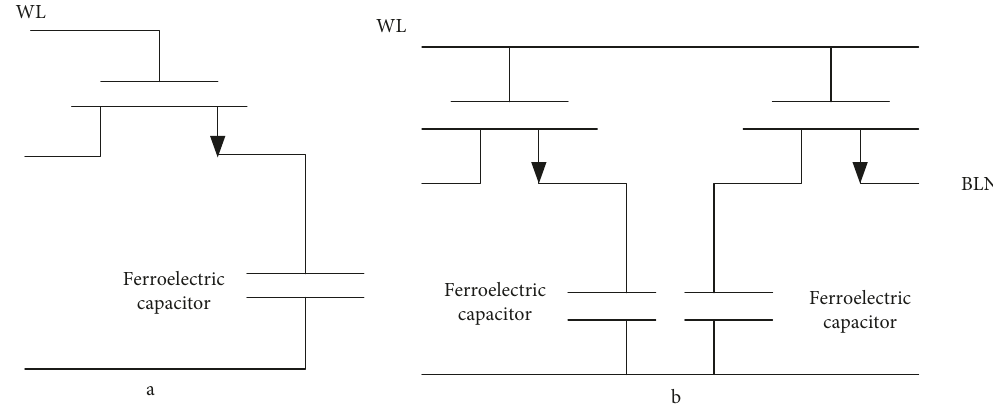
Figure 1: Two storage types of ferroelectric memory: (a) 1T1C type and (b) 2T2C